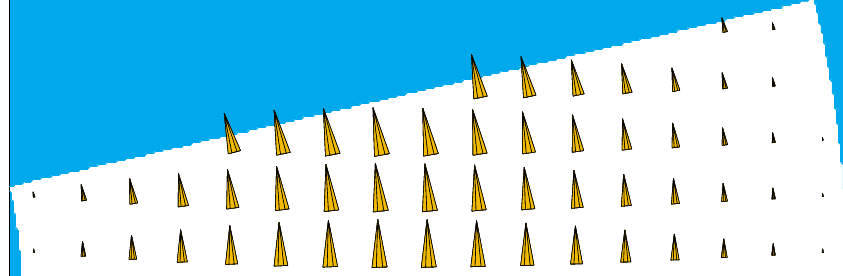
FIG. 6. (Color) MAFIA solution of the lowest-cutoff mode electric field in the wedge-shaped waveguide illustrated in Fig. 5, having a field pattern analogous to that of the rectangular TE 10 . where